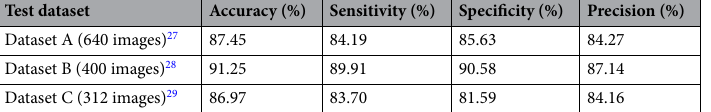
Table 4. Comparative results of cross dataset